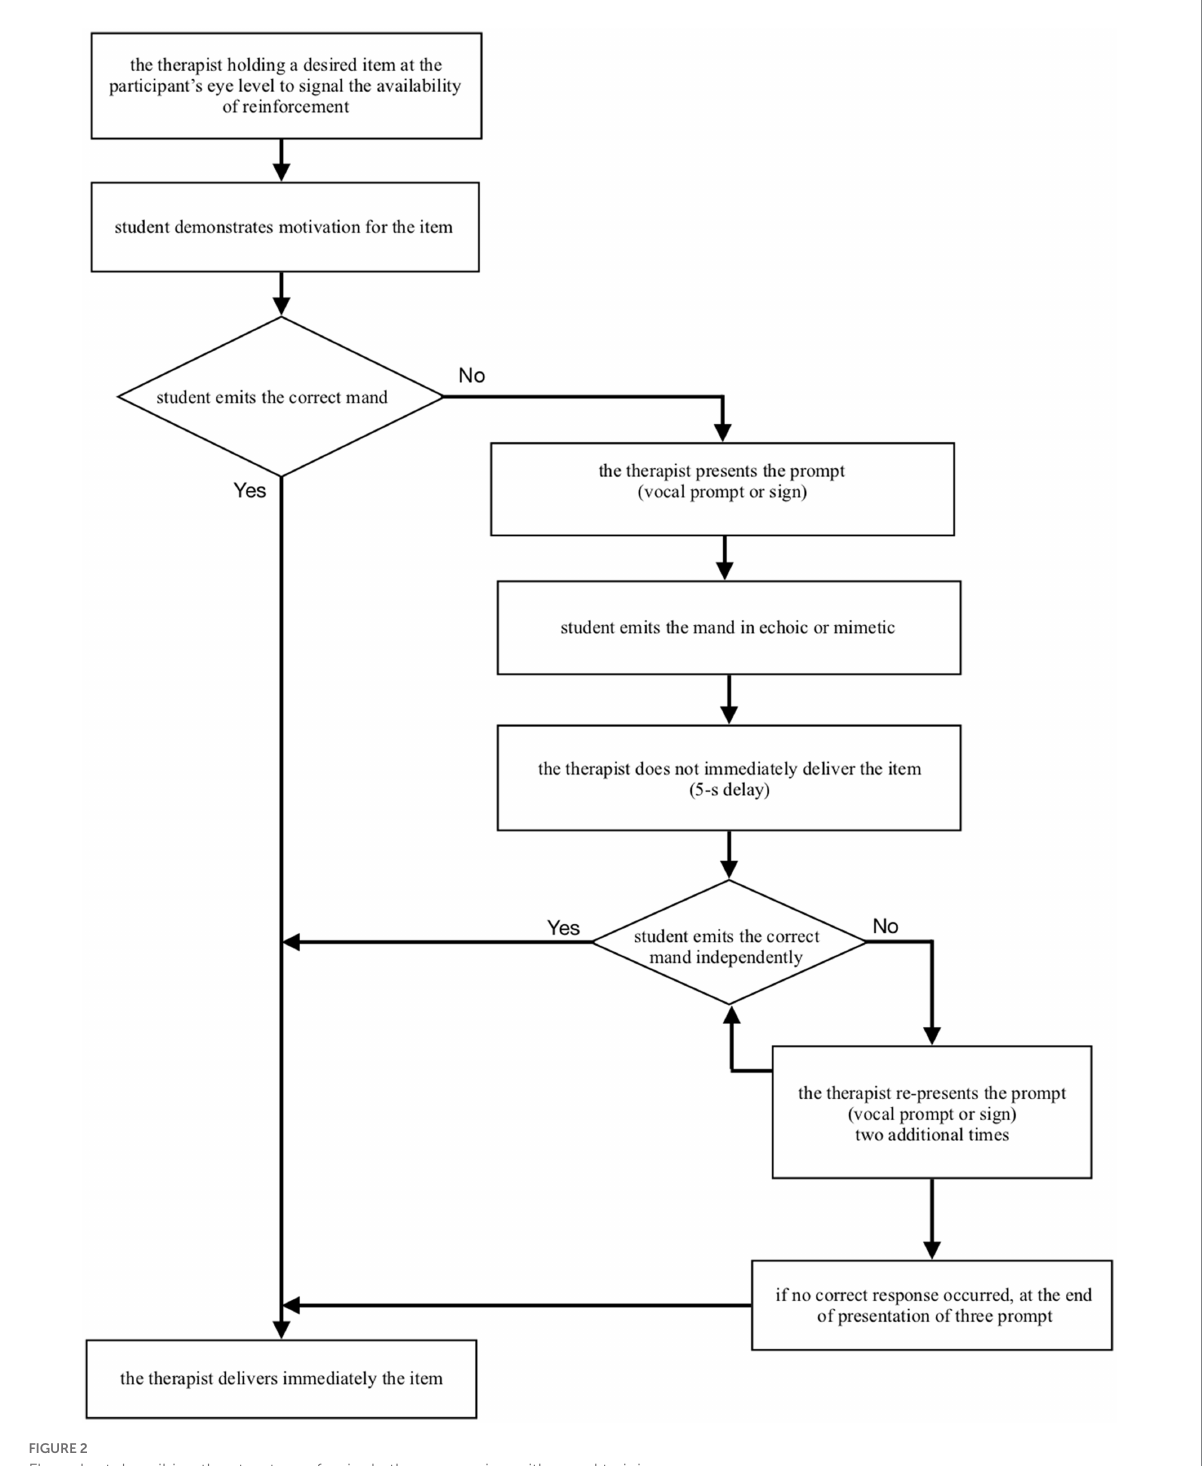
FIGURE 2 Flow chart describing the structure of a single therapy session with mand